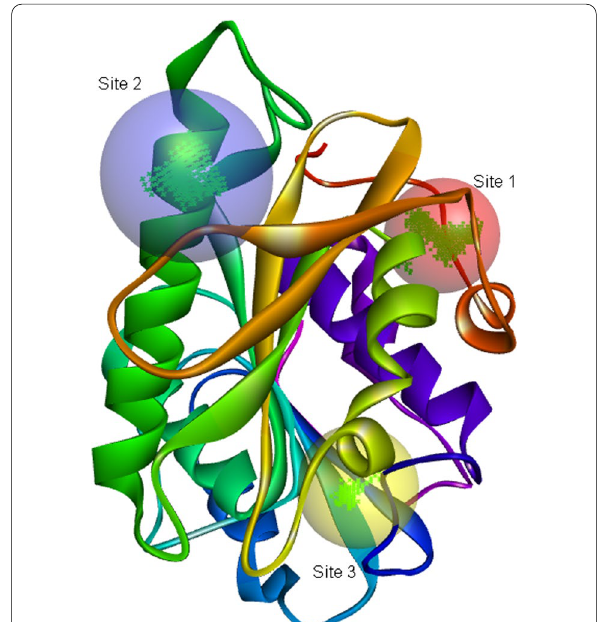
Fig. 2 PET hydrolase enzyme of I. sakaiensis (Chain A) showing active